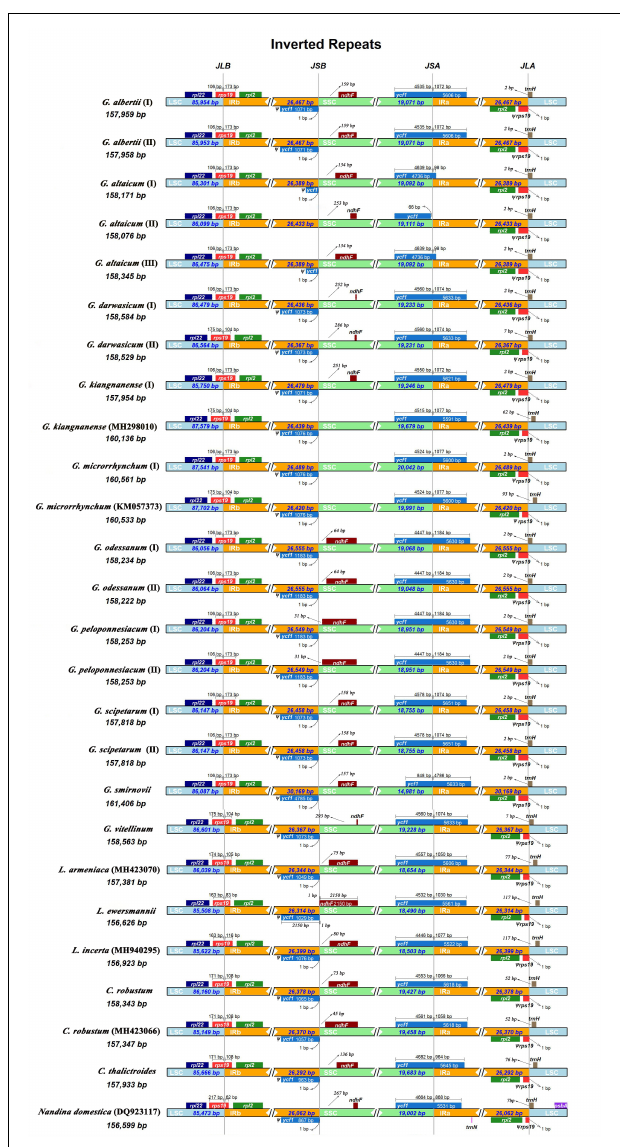
FIGURE 3 | Comparison of the LSC/IRb/SSC/IRa junctions among the 26 complete plastomes of Nandinoideae.